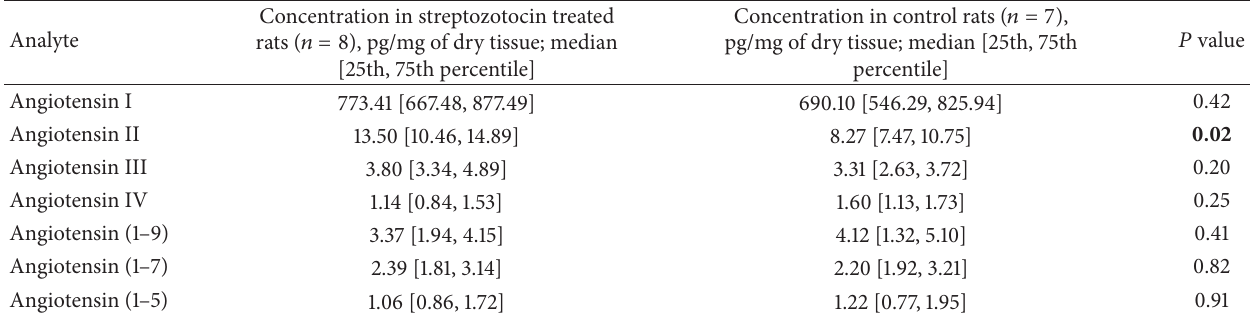
Table 1: Concentrations of the products of metabolism of exogenously added (to a final concentration of 1 𝜇 M) angiotensin I by the aorta fragments of streptozotocin and saline treated animals (pg/mg of dry tissue; median [25th, 75th percentile]). 𝑃 values are from Kruskal-Wallis nonparametric